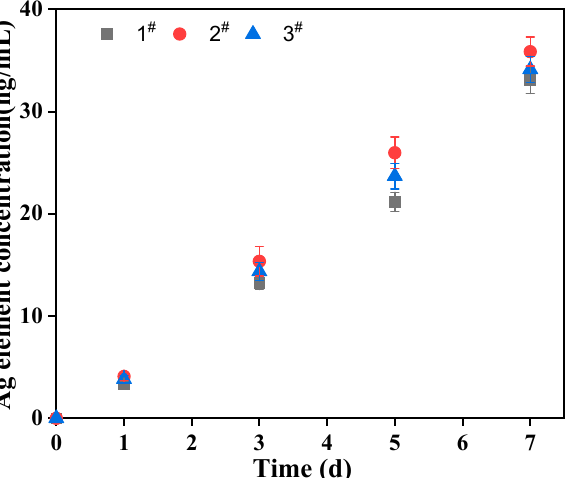
Figure 8. Concentration of Ag element for different immersion time in 0.9% NaCl solution.